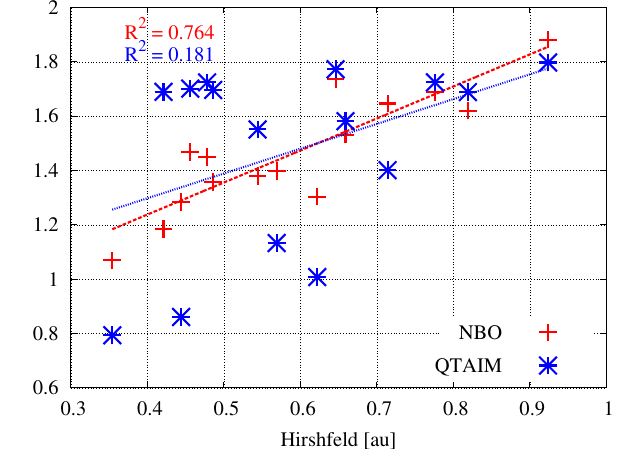
Figure 2. Relationships between the atomic charges of M (M = Be, Mg, Zn; see Table 1) obtained by the Hirshfeld method and either NBO or QTAIM.